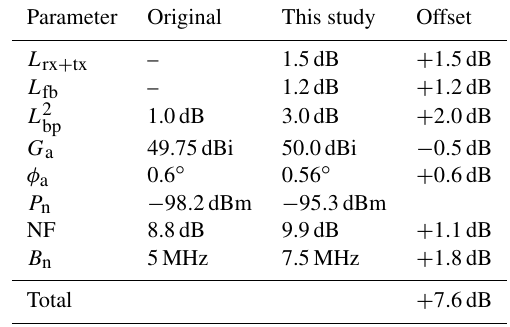
Table 2. Breakdown of the offset between original and new cali- bration for each system parameter. Values for L rx + tx and L fb were already known but not applied in past measurement campaigns. The total offset has to be applied to R c and Z e